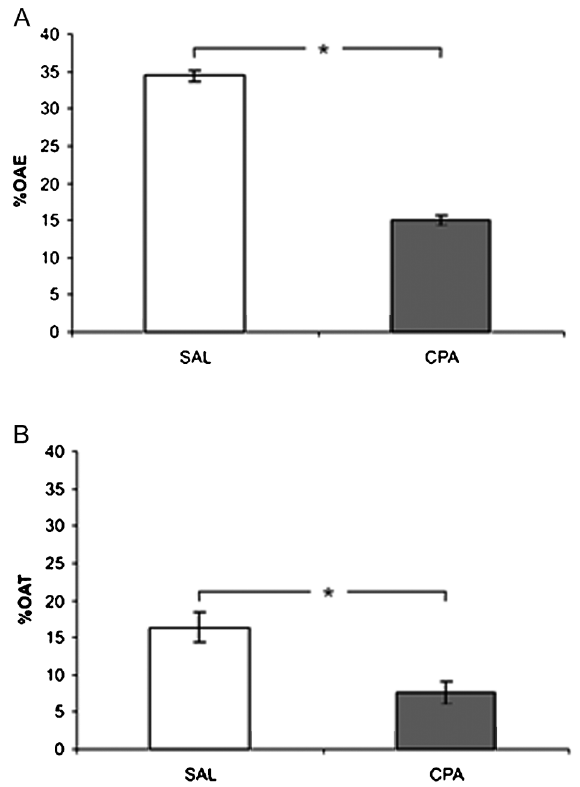
Figure 1. Effects of ip injection of chlorpheniramine (CPA; n = 22) on the percentage of open arm entries (%OAE; A ) and the percentage of time spent in the open arms (%OAT; B ) during Trial 1 (T1). CPA (16 mg/kg, ip ) or saline (SAL) was administered prior to T1. Dataarereported asmeans ± SE.*P , 0.05 for thedifferences between the SAL and CPA groups in T1 (Student t